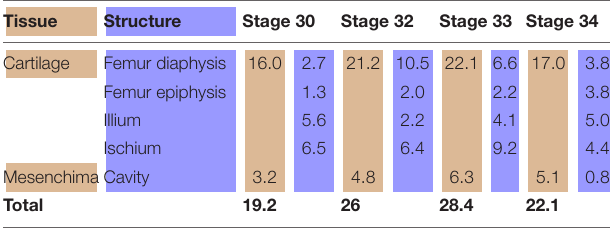
TABLE 3 | Tissues (light brown) and structures (light blue) percentages (%) in relation to the analyzed area ( Gallus gallus ). Tissue Structure Stage